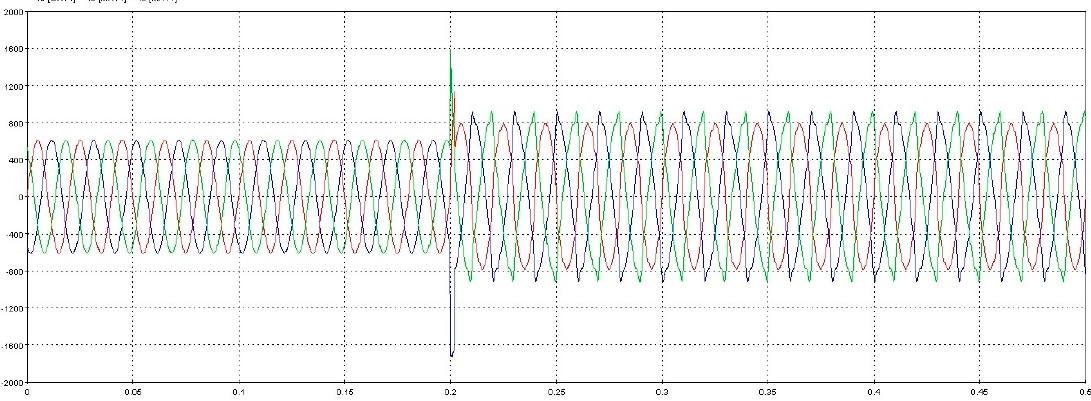
Table 4. Harmonic variation rate of output voltage under two control methods.